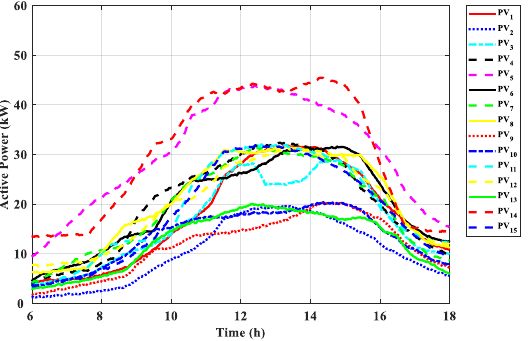
Figure 8. The active output of PV.